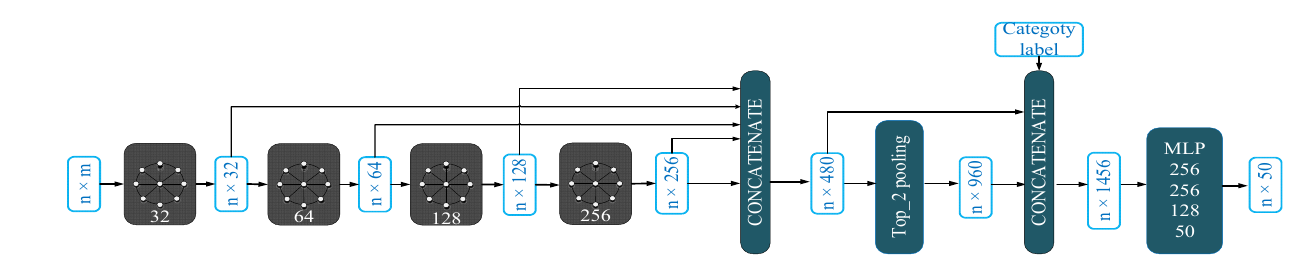
Figure 9. The comparison of key parameters in segmentation.